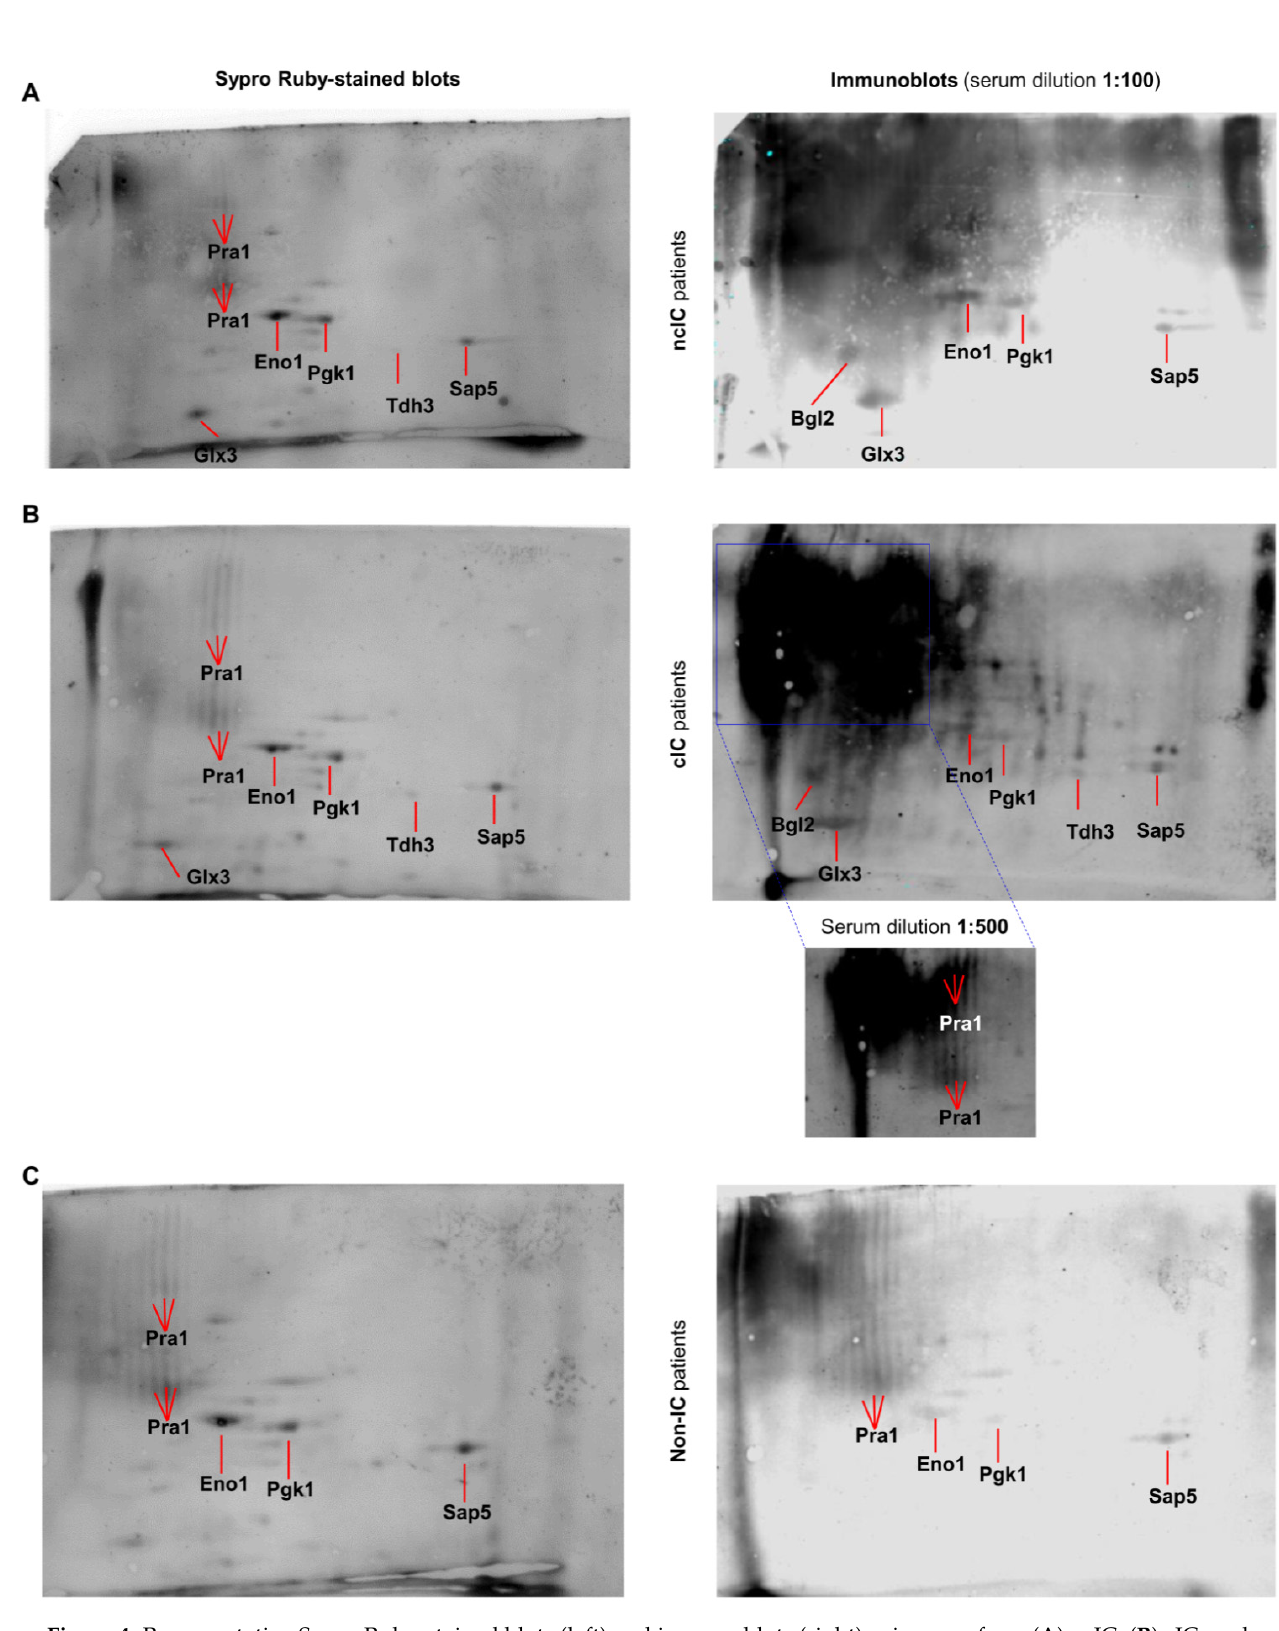
Figure 4. Representative Sypro Ruby-stained blots (left) and immunoblots (right) using sera from ( A ) ncIC, ( B ) cIC, and ( C ) non-IC patients at a dilution of 1:100. In ( B ), a part of the 2-D immunoblot with a lower dilution of sera (1:500) showing defined spots instead of the smear. The immunoreactive proteins identified by MALDI-TOF are